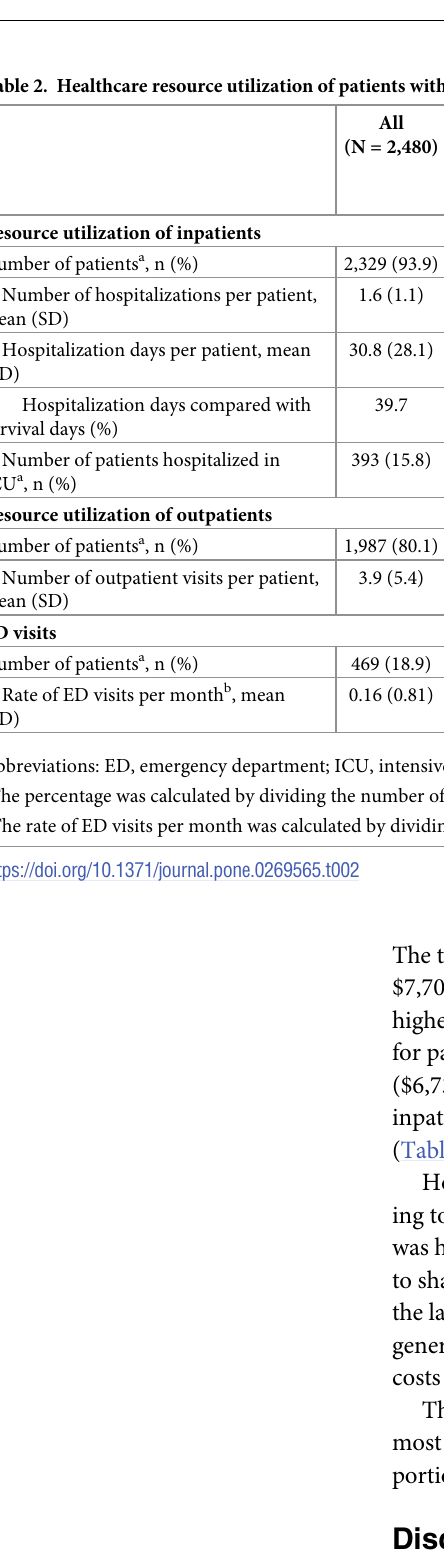
Table 2. Healthcare resource utilization of patients with terminal cancer.